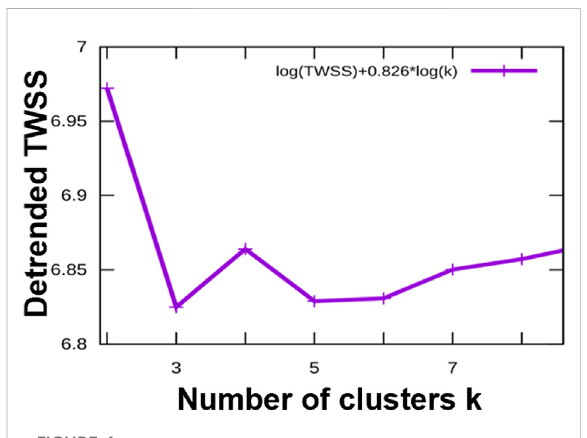
FIGURE 4 The elbow test indicates that the most informative representations of the categories of temporal pro fi les of the differentially regulated piRNAs are classi fi cations into three clusters or into fi ve clusters. X -axis: number of clusters, Y -axis: detrended (residual) Total Within Sum of Squares , a measure of structure unexplained by the clustering.